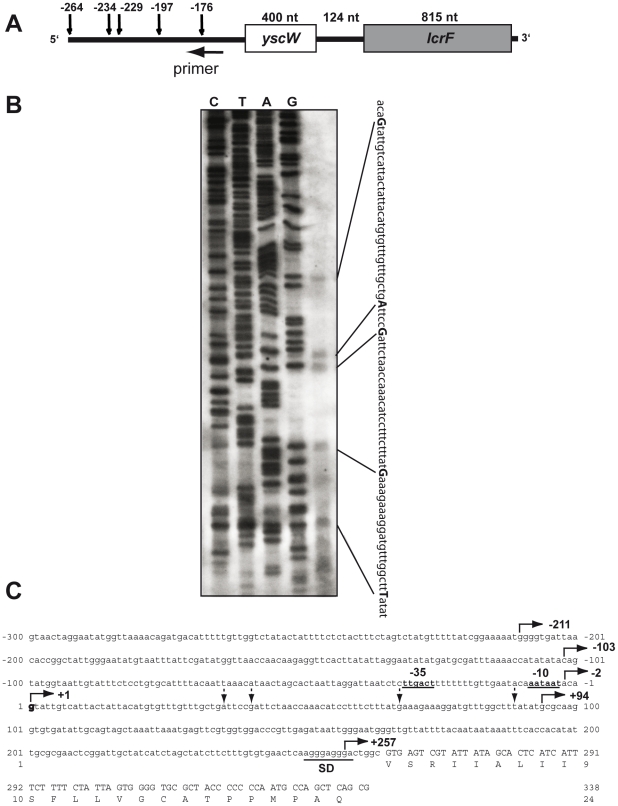
Mapping of the lcrF transcription start site by primer extension analysis.(A) The 5′-ends of the reverse transcription products are indicated by vertical arrows on the schematic presentation of the yscW-lcrF mRNA. The numbers indicate the position of the nucleotide of the 5′-ends with respect to the start codon of yscW. Location of the annealed primer used for primer extension is indicted by a horizontal arrow. (B) Total RNA of Y. pseudotuberculosis YPIII was prepared and used for primer extension analysis. Primers specific for the yscW coding sequence and 20 µg template RNA were applied for primer extension and obtained products were separated on a denaturing 6% polyacrylamide/urea gel. Sequencing reactions performed with the same primer are shown on the left. The sequence of the promoter region is shown on the right and identified 5′-end of the detected primer extension products are given in bold. (C) The regulatory region of the yscW-lcrF operon is shown. The broken arrows indicate the 5′-end points of the promoter deletion constructs and straight arrows show the 5′-end of the degradation products. The −35 and −10 region of the identified promoter is underlined, the transcriptional start site is given in bold, and the Shine-Dalgarno sequence (SD) is indicated.